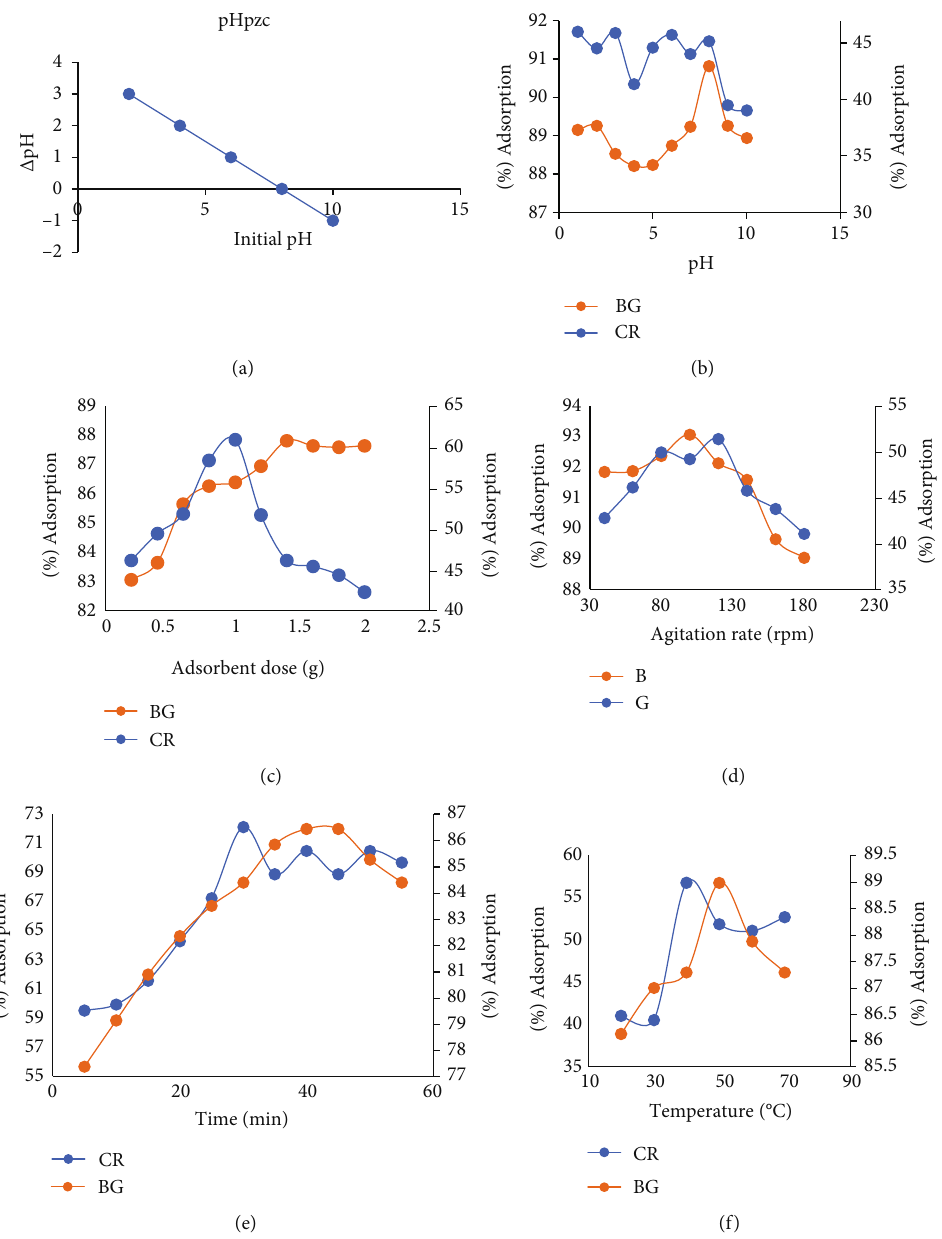
Figure 5: Adsorption parameter for Congo red (CR) ( % age adsorption y- axis on the right hand side) and brilliant green (BG) ( % age adsorption y-axis on the left hand side) adsorption on Brassica oleresea (BO): (a) pHpzc, (b) contact time, (c) adsorbent dose, (d) pH in fl uence, (e) agitation rate, and (f) temperature